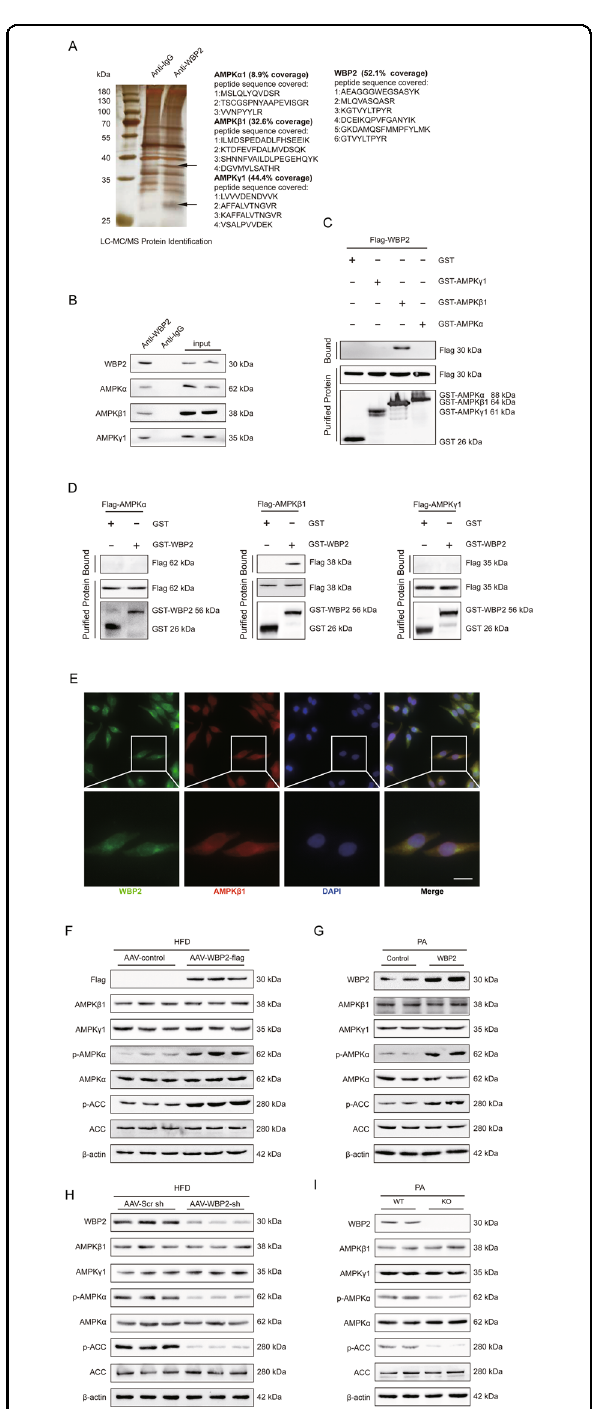
Fig. 5 WBP2 could bind to AMPK β 1 and enhance the AMPK pathway in the liver. A Silver-stained gel of the indicated proteins binding to WBP2, which were coimmunoprecipitated using an anti- WBP2 antibody and identi fi ed via mass spectrometry (MS) in LO2 cells. IgG was used as a control. B Immunoprecipitation and western blot assays using anti-WBP2, anti-AMPK α , anti-AMPK β 1, and anti-AMPK γ 1 to detect the binding of AMPK α , AMPK β 1, and AMPK γ 1 to WBP2 in LO2 cells. IgG was used as a control. C , D GST precipitation assays using anti-GST and anti-Flag to detect the direct binding of WBP2 and AMPK β 1. Puri fi ed GST was used as a control. E WBP2 colocalized with AMPK β 1. Immuno fl uorescence staining for WBP2 (green), AMPK β 1 assays were performed in liver tissues from the AAV-WBP2 mice and the AAV-control mice fed an HFD for 16 weeks to detect the expression of AMPK β 1, AMPK γ 1, AMPK α , p-AMPK α , ACC, and p-ACC. Anti-Flag was used to detect the expression of exogenous WBP2, and β -actin served as the loading control. G Western blot assays were performed in the PA-treated LO2 cells transfected with WBP2 or control to detect the expression of AMPK β 1, AMPK γ 1, AMPK α , p- AMPK α , ACC, and p-ACC. β -actin served as loading control. H Western blot assays were performed in liver tissues from the AAV-Scr sh mice and the AAV-WBP2 sh mice fed an HFD for 16 weeks to detect the expression of AMPK β 1, AMPK γ 1, AMPK α , p-AMPK α , ACC, and p-ACC. β -actin served as the loading control. I Western blot assays were performed in the PA-treated wild-type (WT) or WBP2-knockout (KO) LO2 cells to detect the expression of AMPK β 1, AMPK γ 1, AMPK α , p- AMPK α , ACC, and p-ACC. β -actin served as loading